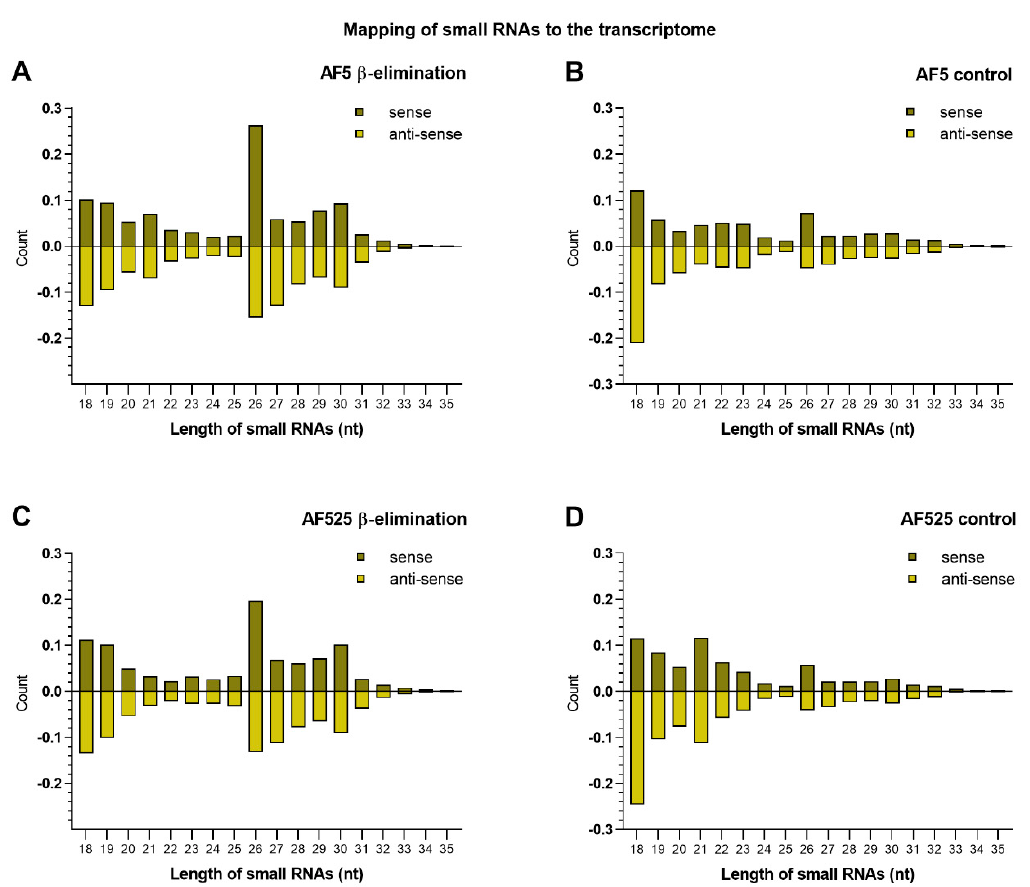
Figure 5. Length distribution of small RNAs from AF5 and AF525 cells mapping to the transcriptome of Ae. aegypti Liverpool AGWG, version AaegL5.2 . Left panel side ( A , C ) shows treated samples of AF5 and AF525 cells, right panel side shows the results for untreated controls ( B , D ). x -axis displays the different lengths of small RNAs from 18 nt to 35 nt and y -axis displays the amount of small RNAs normalized to clean reads. Positive numbers are RNAs mapping to sense RNAs (dark green) while negative numbers map to anti-sense RNAs (light green). Two independent experiments were carried out and the results of one representative experiment are shown here (run I).